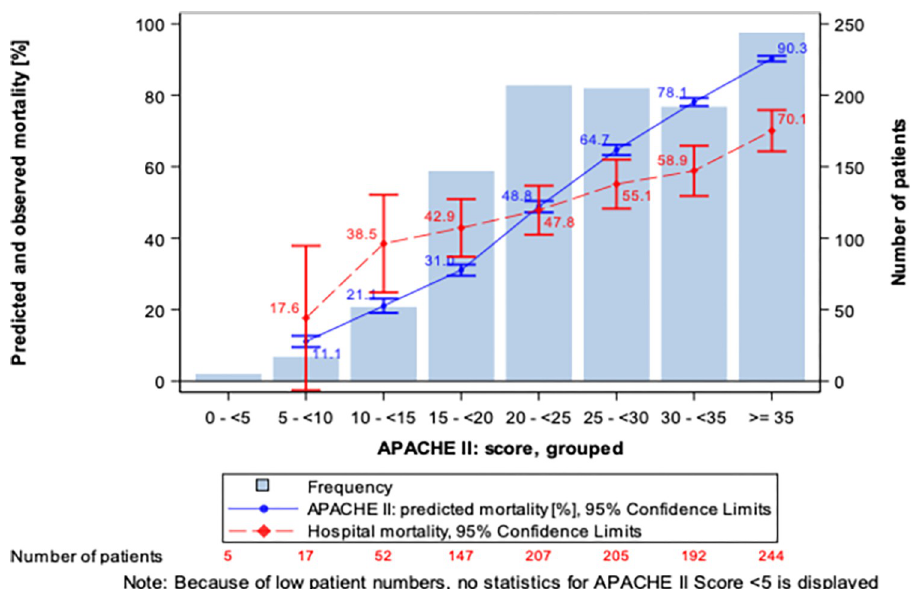
Fig 2. Actual and predicted mortality in the whole sample. ITT, number of patients. See text for explanation.